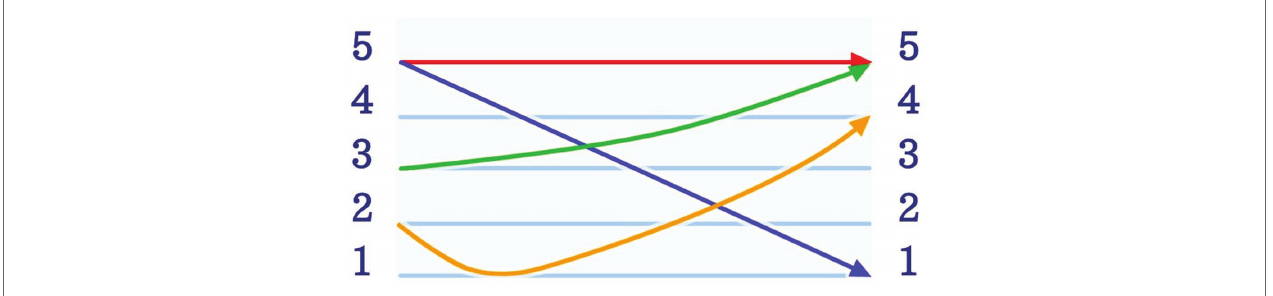
FIGURE 1 | The figure illustrates the tone chart of the five Mandarin tones. According to the traditional tone chart, the red line shows the first tone which is described as a “high level tone” (5-5). Furthermore, the green line represents the second tone which is defined as the “(high) rising tone” (3-5), while the orange line shows the third tone, the “falling-rising tone” (2-1-4). Finally, the fourth tone determined as a “falling tone” (5-1) is shown by the blue line (Chao,